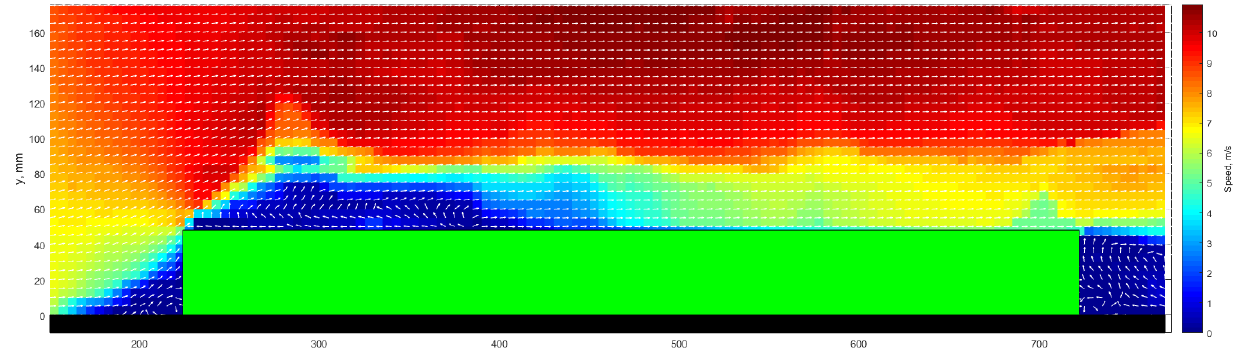
Fig. 6. Average velocity field obtained by PIV-methods. The color shows the